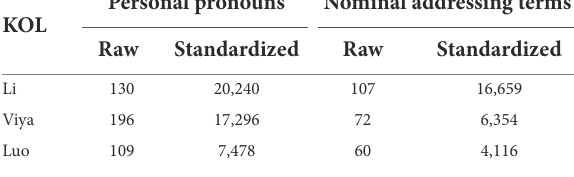
TABLE 6 Frequencies of KOLs’ addressing